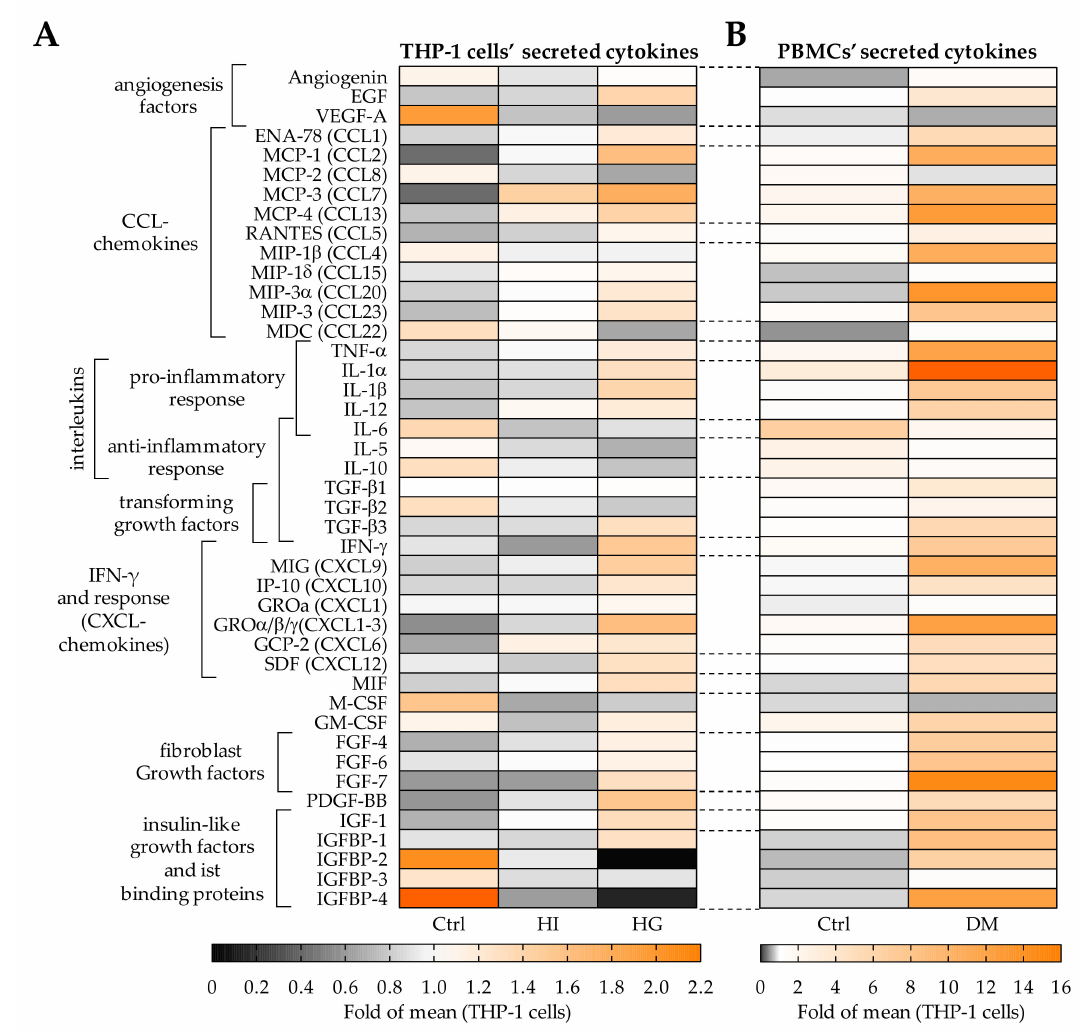
Figure 5. Pre-/diabetic conditions alter the composition of factors secreted by THP-1 cells and PBMCs. ( A ) THP-1 cells were cultured under normoglycemic (Ctrl), hyperinsulinemic (HI), or hyperglycemic (HG) conditions for 48 h to obtain THP-1 cell conditioned medium. ( B ) PBMCs isolated from type 2 diabetics (DM) and respective controls (Ctrl) were cultured for 48 h to obtain PBMC conditioned medium. Relative cytokine levels in the conditioned media (pools of N = 6) were determined using the human Cytokine Array C5 and the human Growth Factor Array. Mean data are presented as heat